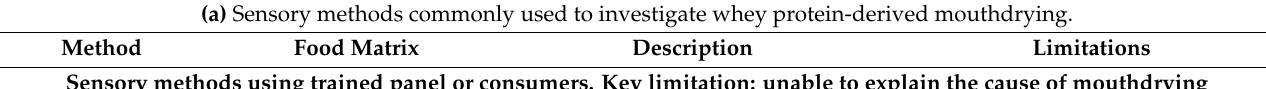
Table 3. ( a ) Sensory methods commonly used to investigate whey protein-derived mouthdrying. ( b ) Physiochemical analysis commonly used to investigate whey protein-derived mouthdrying. ( c ) In vivo analysis commonly used to investigate whey protein-derived